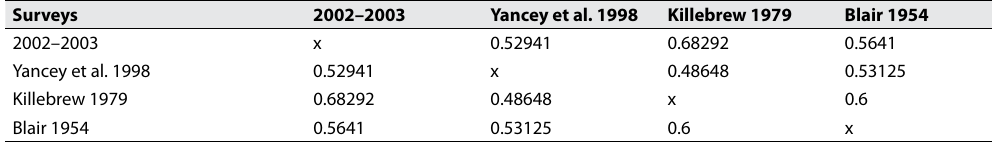
Table 6. Jaccard similarity coefficient (J) for the four mammal studies conducted in LMNRA and the vicinity.